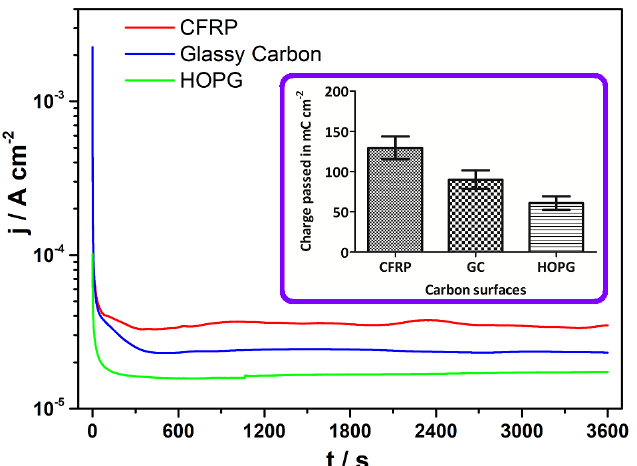
Figure 7 . Averaged chronoamperometric profile from hextuple measurements of each carbon sur- face (Inset is the output from the statistical comparison of charges passed during 1 − h polarization of CFRP, HOPG, and glassy carbon in 50 mM NaCl at − 1000 mV SCE from hextuple chronoam- perometric tests, respectively). (Error bars indicate standard error of means (SEM)).